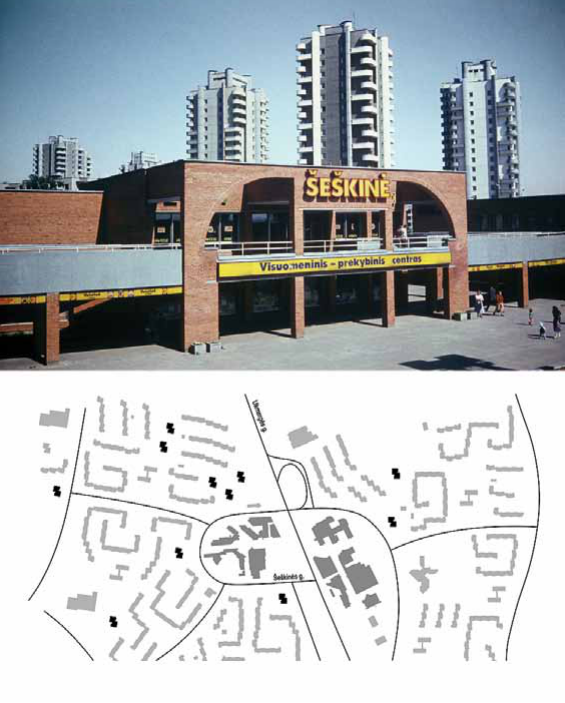
Fig. 6. Tower blocks in Šeškinė: view from Šeškinė shopping centre, layout of the